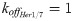
Plots of multiple cells oscillatory clocks versus time.Each lattice is a single cell. Each five minute interval is marked by two columns of 32 cells. The mean phases of oscillation over all cells are marked by the magenta lines. The data is that of Fig 2. A: koffHer1/7=1 min-1. The cells remain in synchrony and no salt and pepper pattern is generated. B: koffHer1/7=1/3 min-1. The cells gradually drift out of synchrony to a salt and pepper pattern over 6–7 oscillation cycles. C: koffHer1/7=1/6 min-1. Cell oscillations quickly desynchronise and tend to a salt and pepper pattern in 2–3 oscillation cycles. The figures demonstrate that, gradually, the number of cells oscillating in phase, within the magenta periods, decreases as noisy gene regulation causes the cell clocks to gradually drift out of synchrony from one another. The result is a salt and pepper pattern. As this salt and pepper pattern is reached, somites will not form correctly. (Compare to the wildtype case of Fig 5E.)